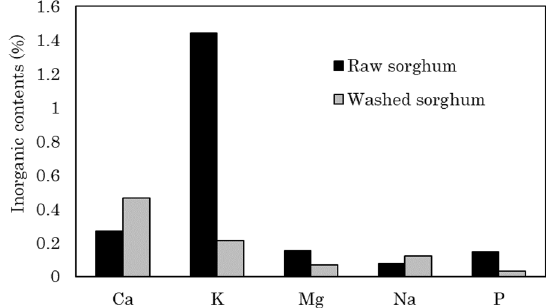
Fig. 2 Atomic O/C and H/C ratios of raw sorghum, washed sorghum, and